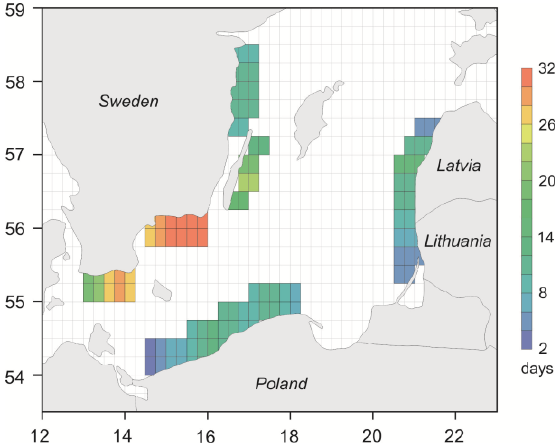
Figure 5. Seasonal (June – August) number of days with upwelling in different coastal regions.